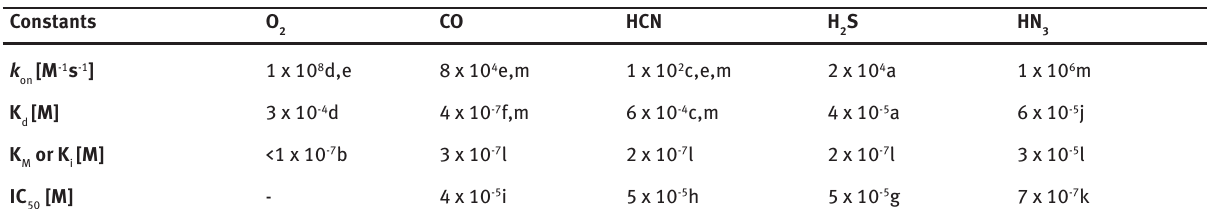
Table 3: A compilation of binding equilibrium, inhibition and the forward binding rate constants for COX’s binding of various Type II ligands at physiological conditions.